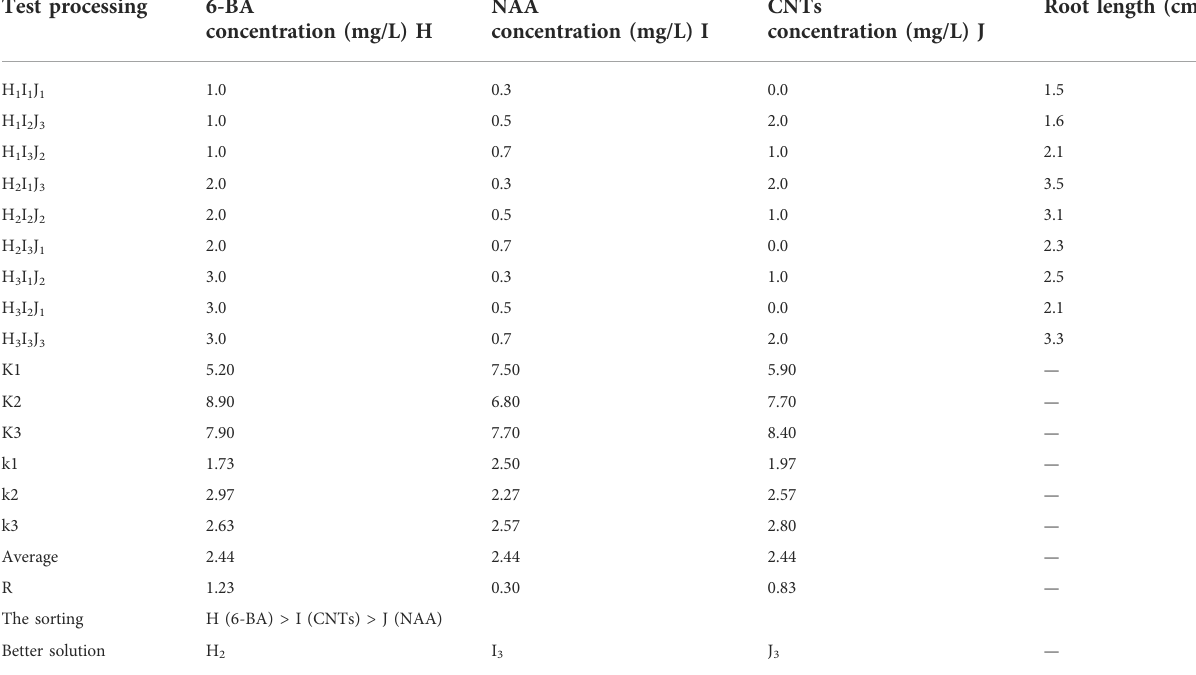
TABLE 3 Statistical results of orthogonal experimental design for rooting. Test